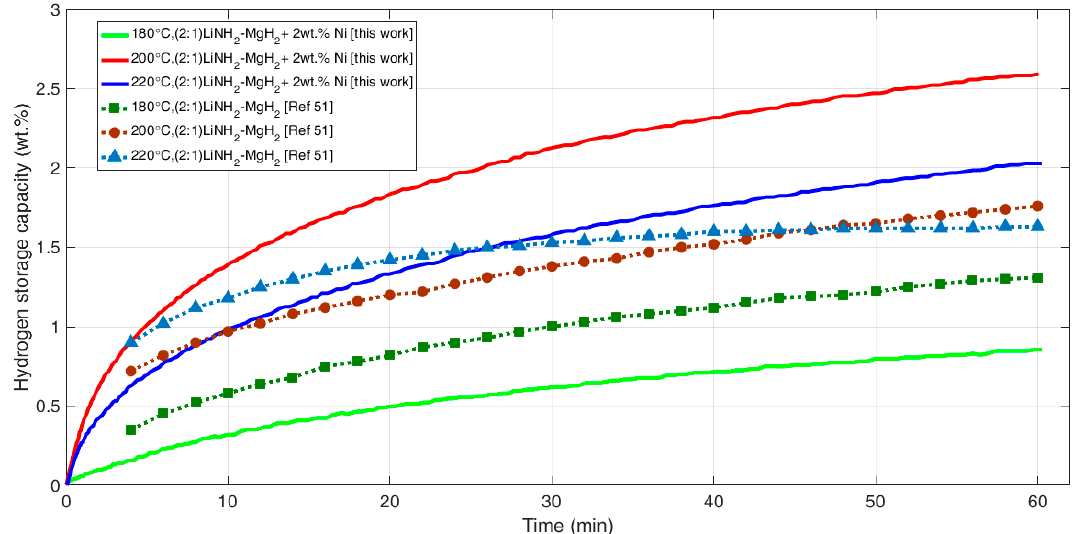
Figure 6. Absorption kinetics of 2LiNH 2 -nanoMgH 2 + 2 wt. % Ni and the base material 2LiNH 2 -MgH 2 at 180, 200, and 220 °C [54].